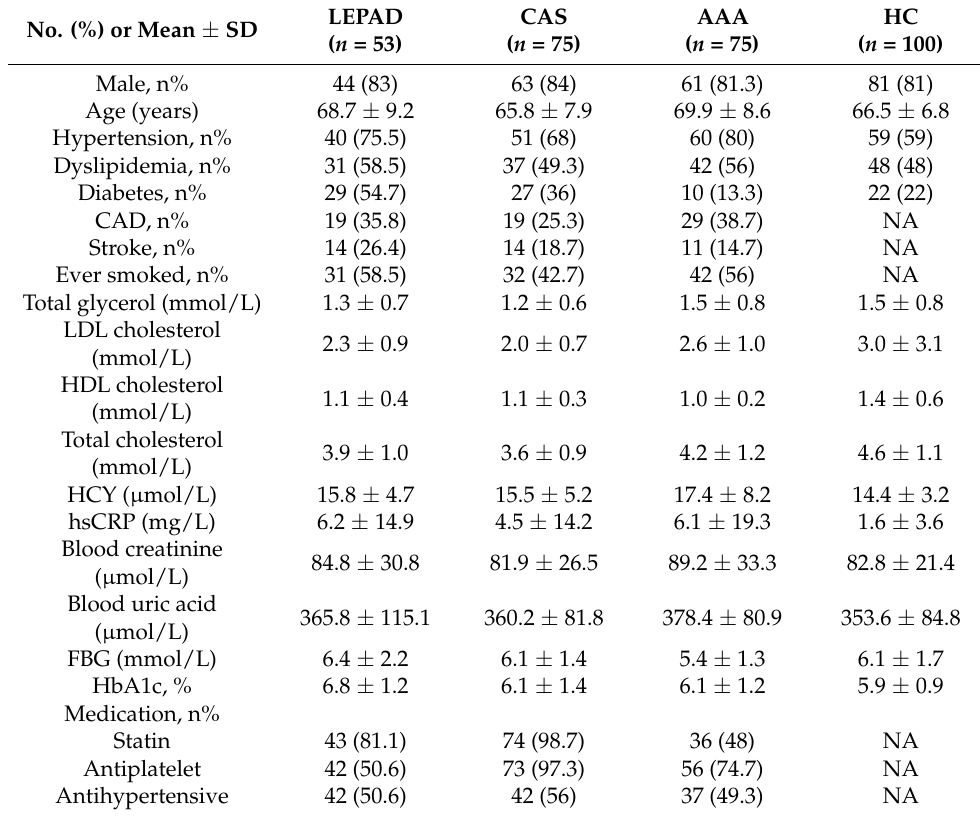
Table 1. Clinical characteristics of patients.